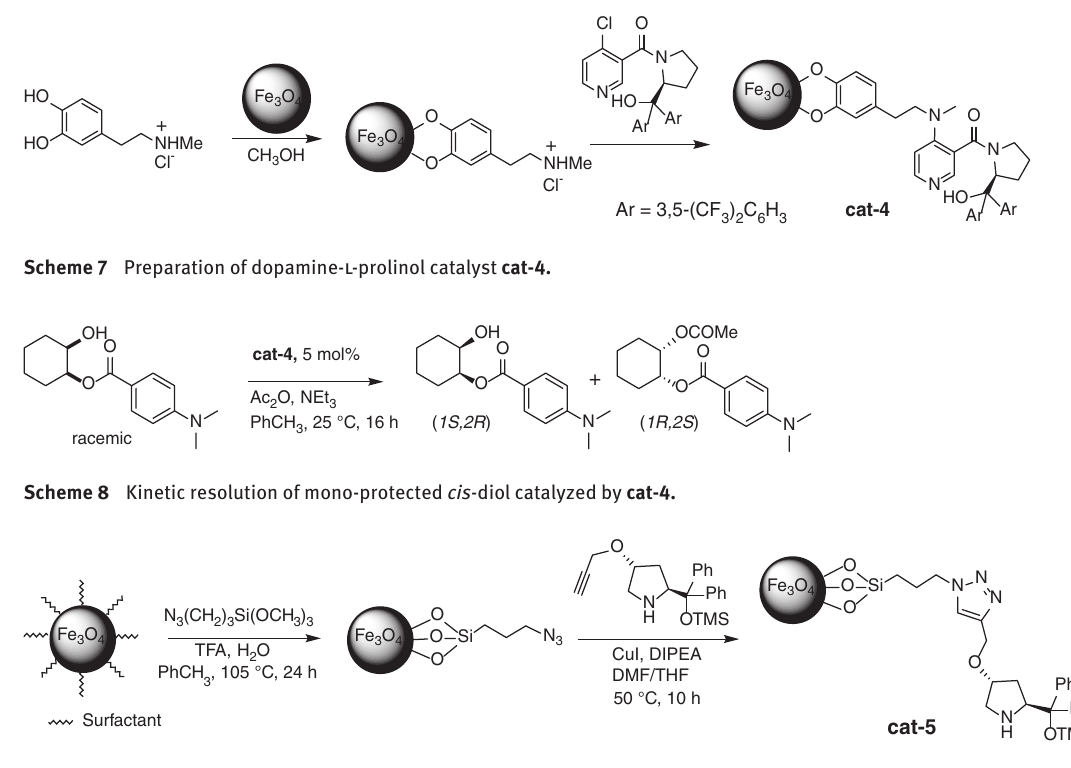
Scheme 9 Preparation of ( S )- α , α -diphenylprolinol catalyst